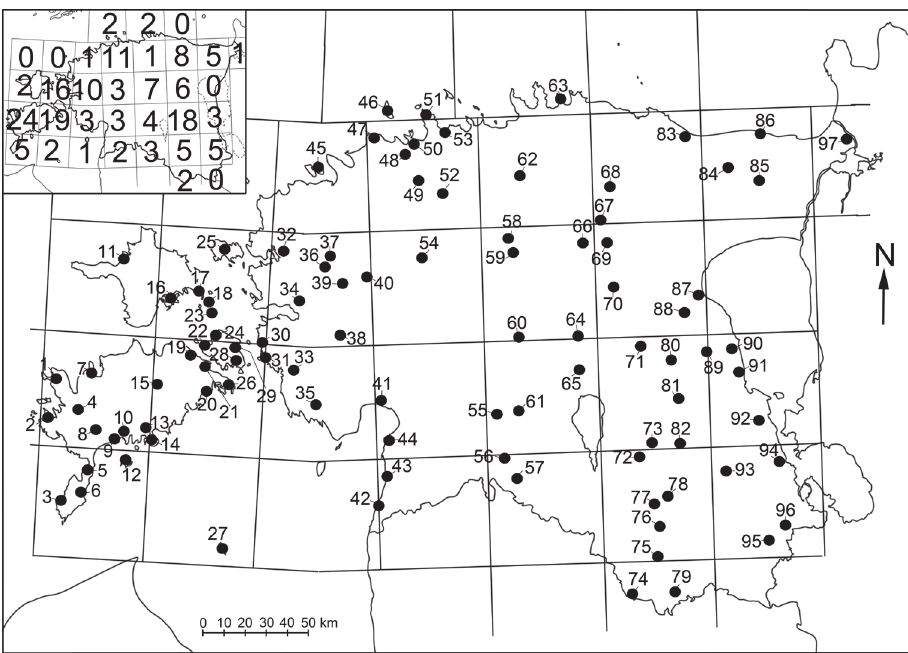
Figure 1. Collecting localities of Estonian Oniscidea and numbers of sampled localities per 50 × 50 km UTM squares. For further details, see Table